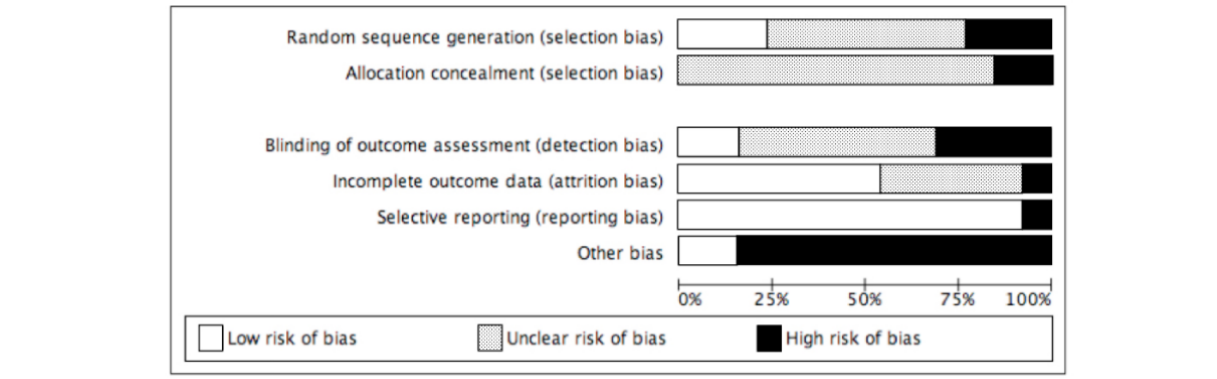
Figure 2. Risk of bias assessment.